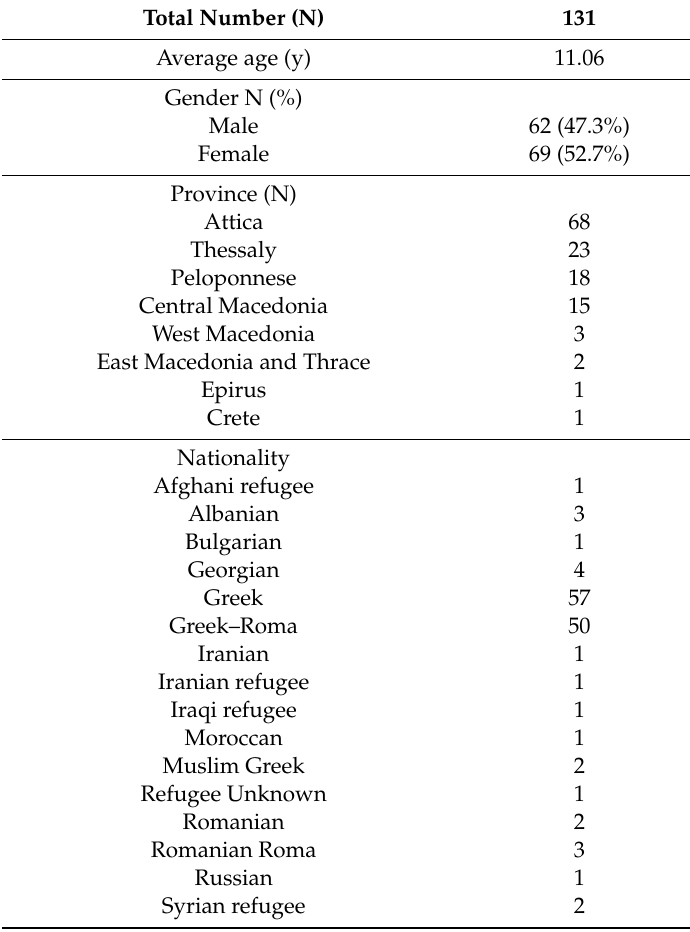
Table 1. Epidemiological characteristics of the genotyped MeV